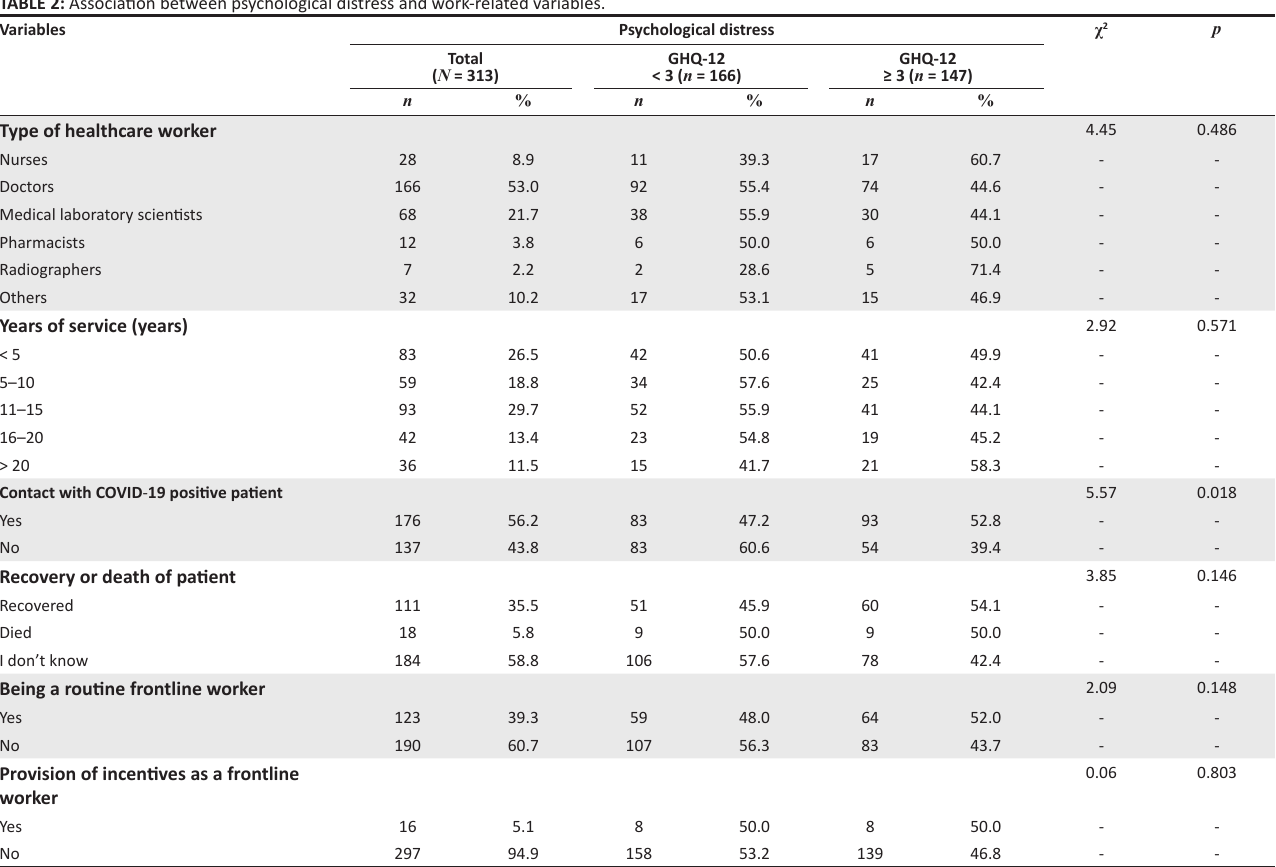
TABLE 2: Association between psychological distress and work-related variables.